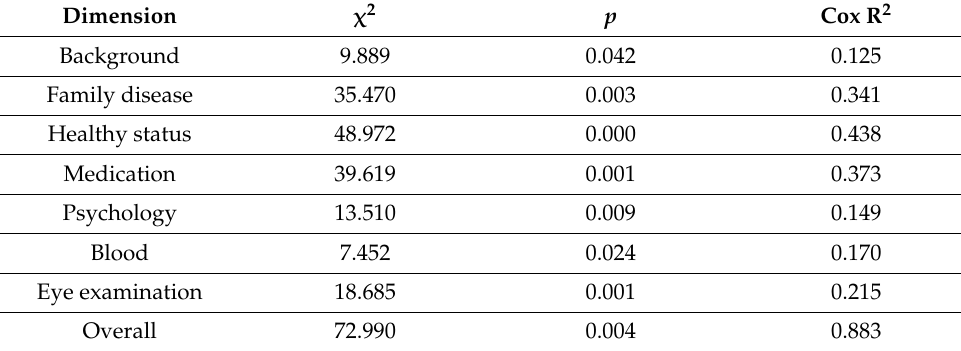
Table 5. Multinomial logistic regression analysis in each dimension (controlling age variance).